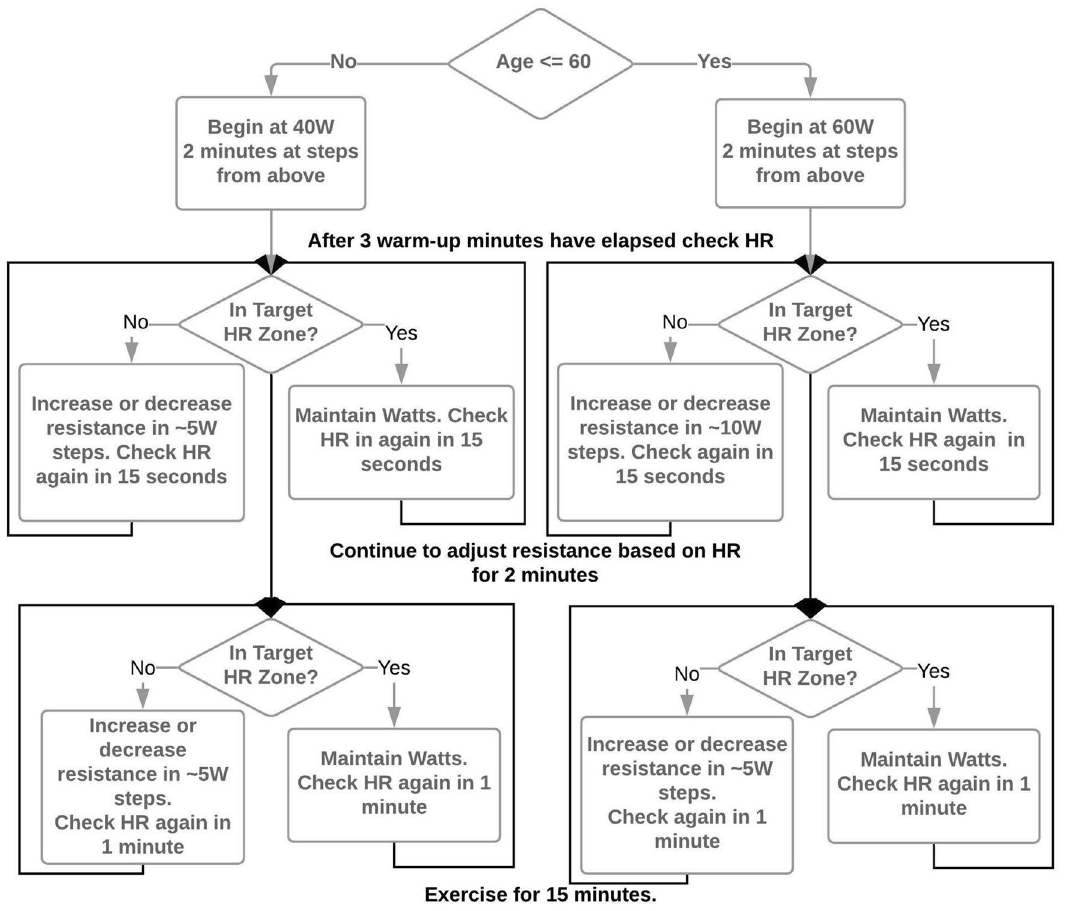
Figure 1. Age-dependent resistance and cadence decision algorithm for standardizing workload to achieve target heart